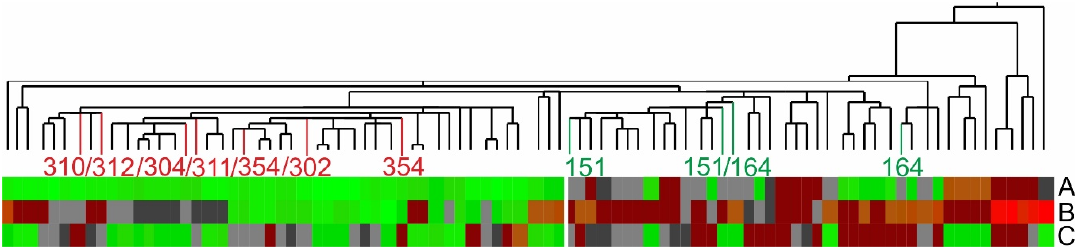
Figure 4. Hierarchical clustering analysis with quotient values A, B, and C of protein ion signal areas of the “development” test set. This set contains the second measurement series, MS2, of CTRL I and FGR I plus the third and fourth measurement series, MS3 and MS4, of CTRL II and FGR II serum samples ( n = 86). Quotients A to C are arranged from top to bottom. Color code for the quotient values; red: high values; brown: medium high; grey: medium low; green: low. Patient numbering is as in Supplemental Tables S1 and